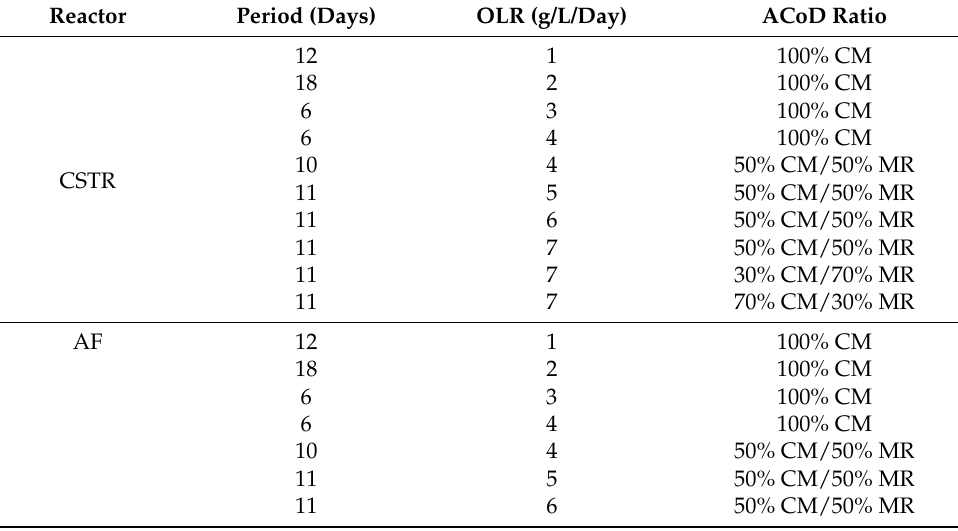
Figure 3. Schematic diagram of anaerobic filter with perforated membrane (AF) reactor.